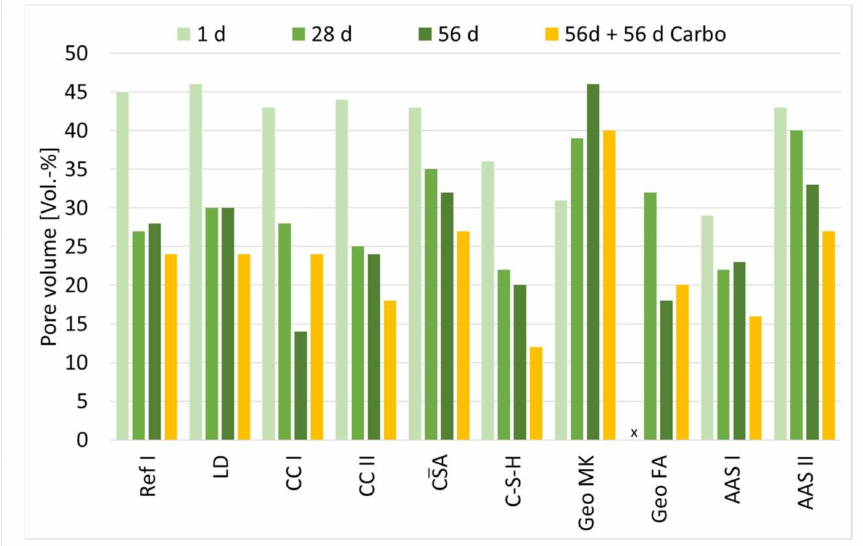
Figure 3. Pore volume of hydrated and carbonated paste